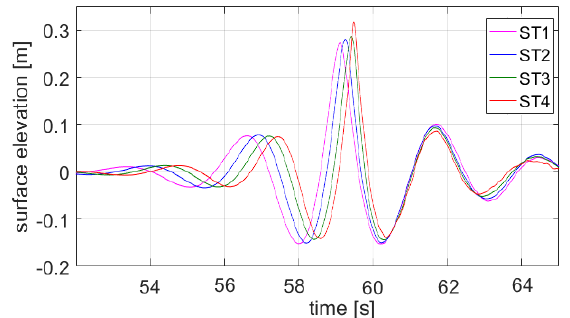
Figure 4. ST surface-elevations